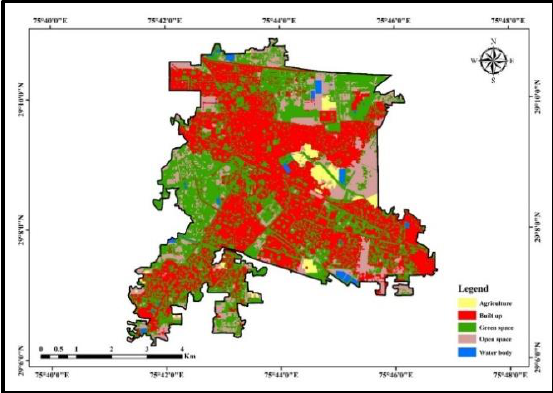
Figure 3. LULC including green space Map of HMC The coverage of agriculture is 2.49 % of the total